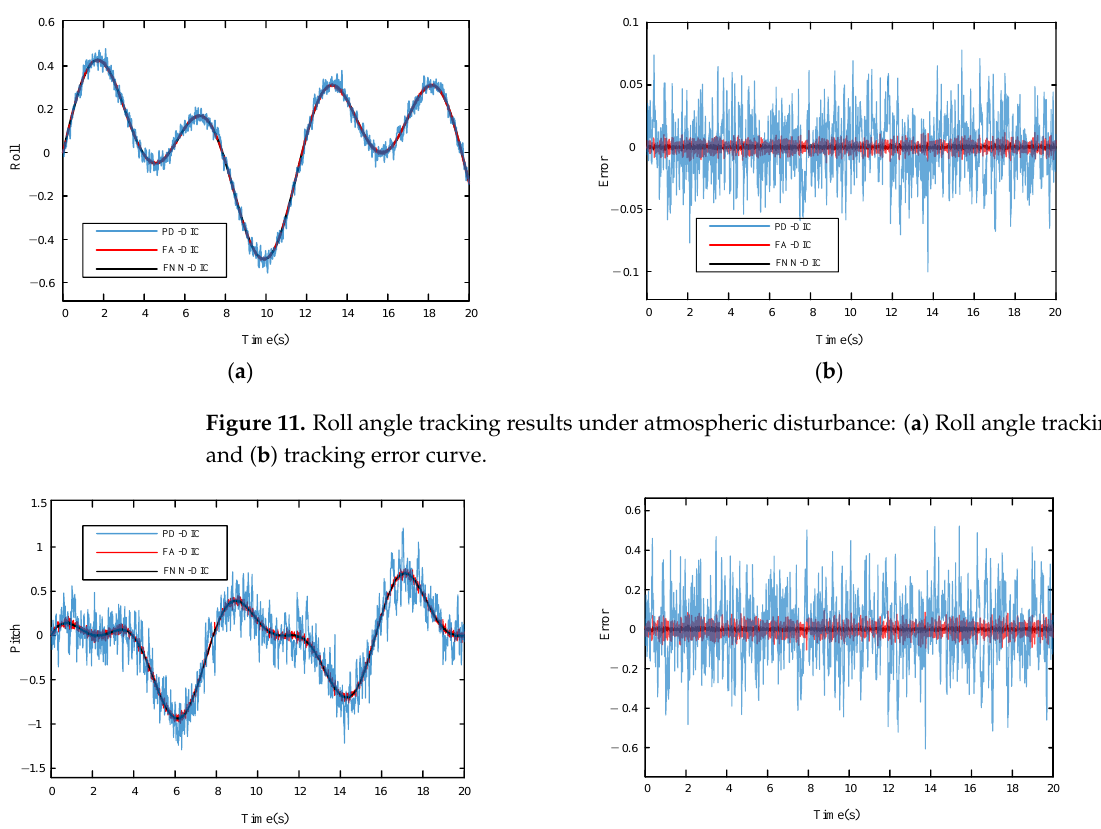
( b ) Figure 13. Yaw angle tracking results under atmospheric disturbance: ( a ) Yaw angle tracking curve, and ( b ) tracking error curve. Table 5. Maximum tracking error of attitude angle under atmospheric turbulence. Channel